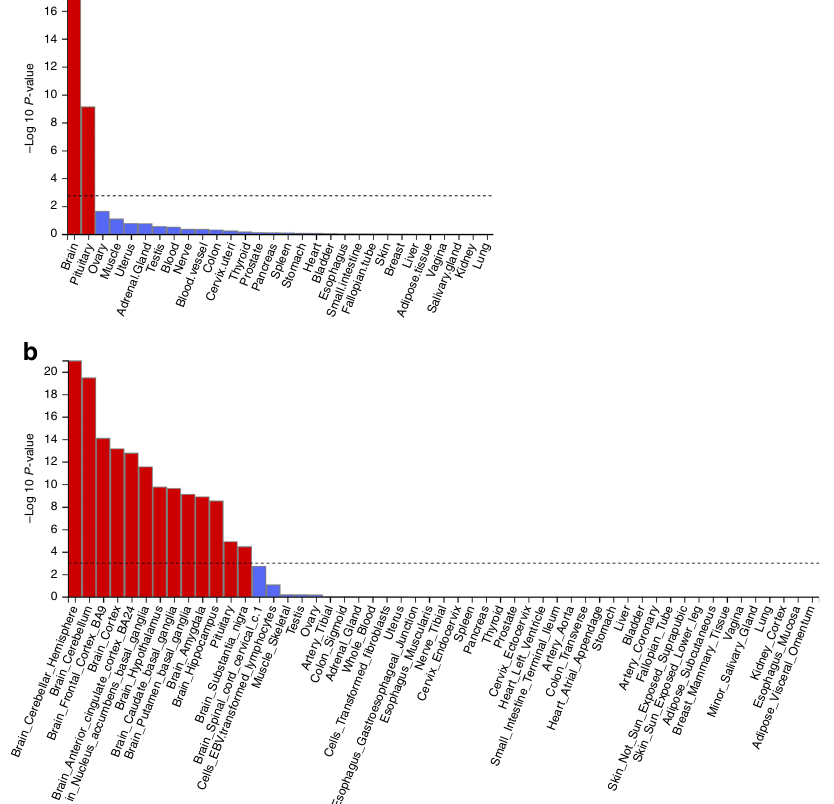
Fig. 4 MAGMA tissue expression analysis results. Per-tissue enrichment of expression of chronotype genes based on GTEx RNA-seq data for a 30 general and b 53 speci fi c tissue